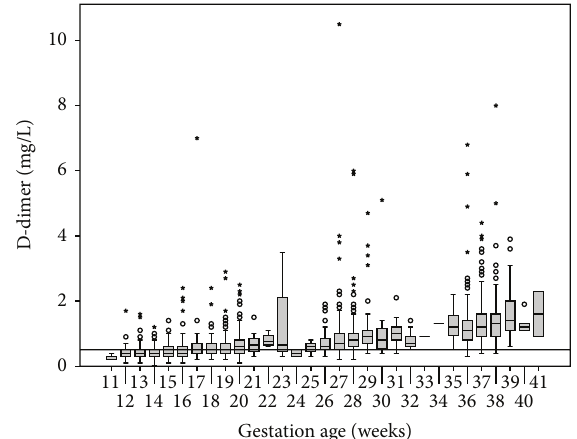
Figure 2: D-dimer during pregnancy. The box plots represent the central distribution of the D-dimer concentration (25th–75th per- centile), while the horizontal bar in the middle of each box plot represents the median value. The “whiskers” represent the range of values, excluding outliers (circles) and extreme values (asterisks). The results are provided for each gestational week (11–41). The horizontal line represents the conventional threshold of 0.5 mg/L